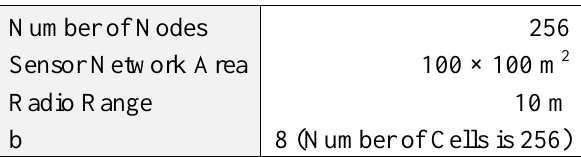
Table 3. Parameters for running